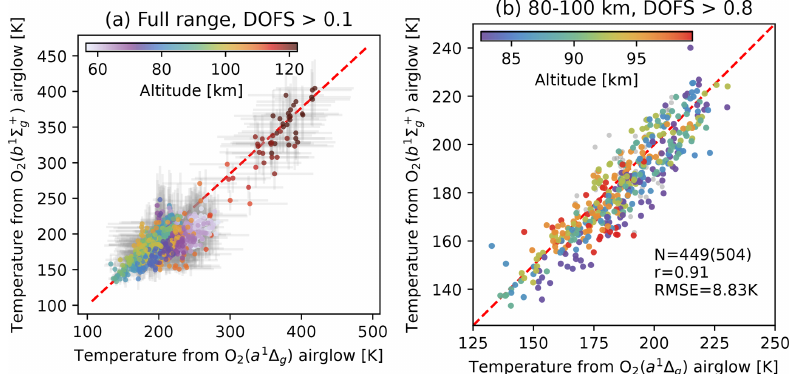
Figure 13. (a) Temperatures retrieved from both 1 (cid:49) and A bands in an MLT mode orbit on 19 January 2010. Gray error bars indicate the 95% confidence intervals approximated by twice the posterior error standard deviation. Data are filtered by DOFS greater than 0.1 for both bands and colored by altitude. The red dashed line is 1:1. Panel (b) is similar to panel (a) but only shows data between 80 and 100km. Data with DOFS greater than 0.1 but less than 0.8 are in gray ( N = 504). Data with DOFS greater than 0.8 are colored by altitude ( N = 449). The Pearson correlation coefficient ( r ) and root mean squared error (RMSE) are also labeled.